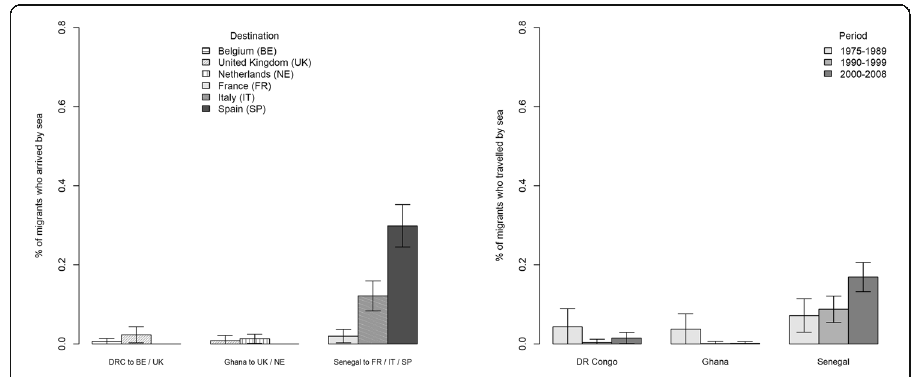
Fig. 12 Percentage of African migrants who travelled by sea (1975 – 2008), by origin, country of residence (at the time of the survey), and period of arrival. Source: MAFE Biographical surveys in Europe. Measure: Percentage of migrants who travelled by sea at some stage in their journey to Europe. Weighted results, 90% confidence